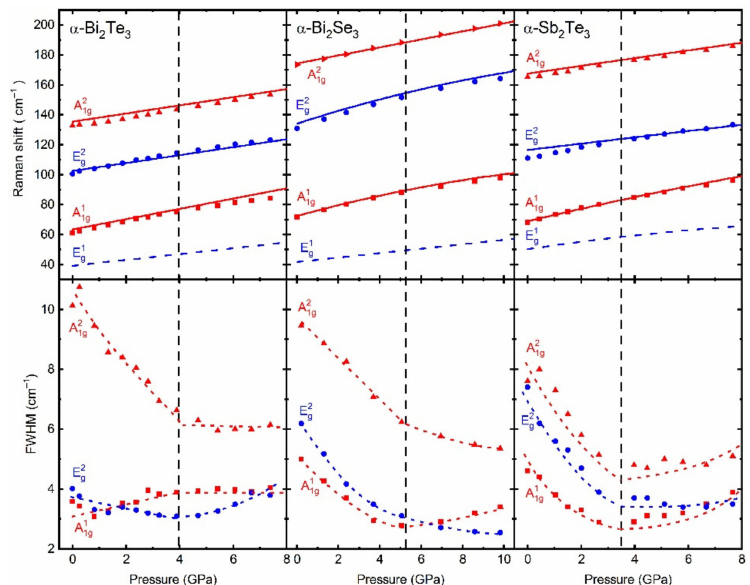
Figure 3. (Top) Experimental (symbols) and theoretical (lines) pressure dependence of the Raman-active frequencies in the tetradymite phase of Bi 2 Te 3 , Bi 2 Se 3 , and Sb 2 Te 3 . Solid (dashed) lines correspond to experimentally observed (non- observed) Raman-active modes. (Bottom) Experimental (symbols) pressure dependence of the Raman-active linewidths (FWHM) of the three compounds. Lines are guides to the eye. Dashed vertical lines indicate the pressure at which the electronic topological transition